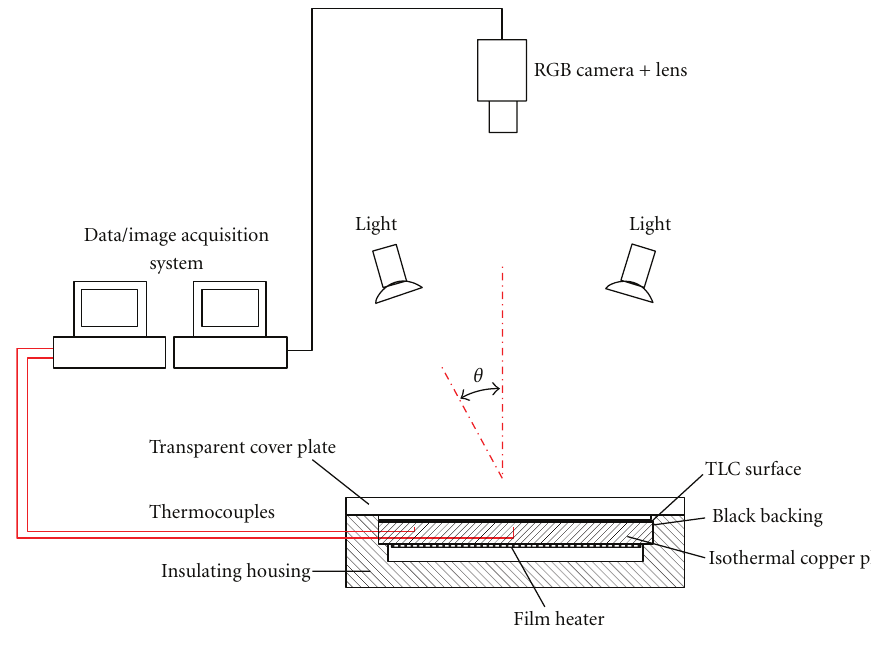
Figure 1: The TLC calibration experimental